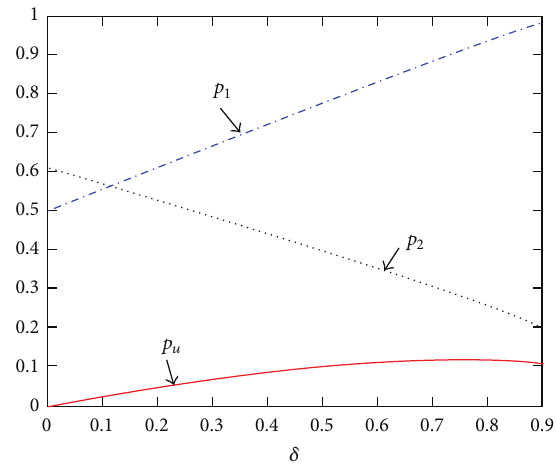
Figure 3: Changing trends in